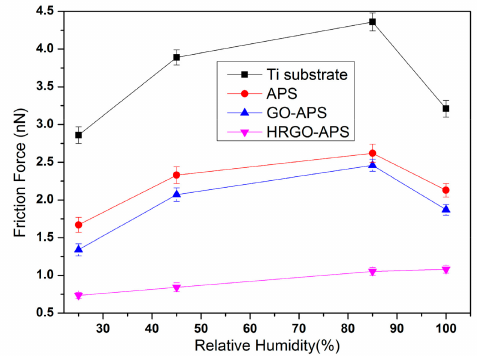
Figure 15. Variation of friction forces of deposited Ti substrate and prepared coatings under various RHs (Applied Load: 70 nN, Scan area: 2 µ m × 2 µ m, Scan rate: 2